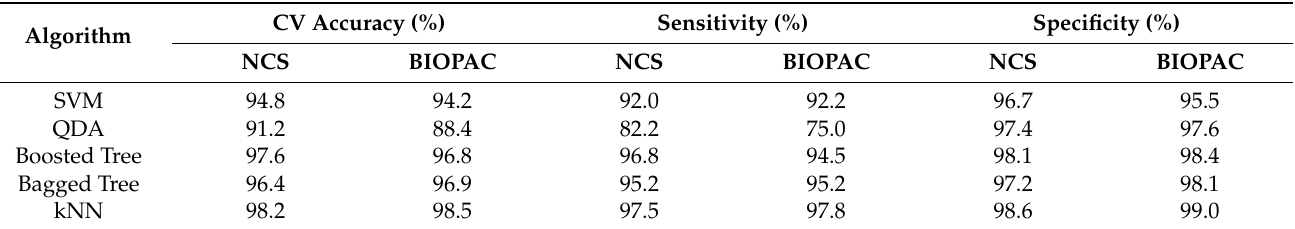
Table 2. Classification algorithm